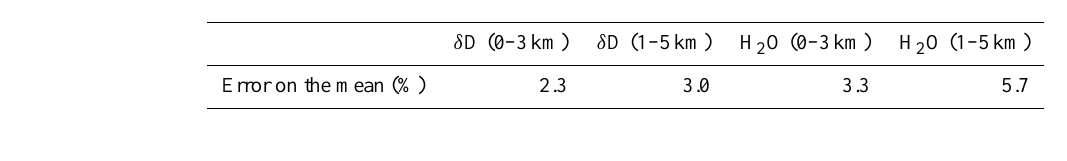
Table 1. Annual mean for the error on the mean for δ D and H 2 O and both altitude ranges (0–3km and 1–5km). The error is calculated as: q ( Err T 2 + Err Meas noise 2 )/N .